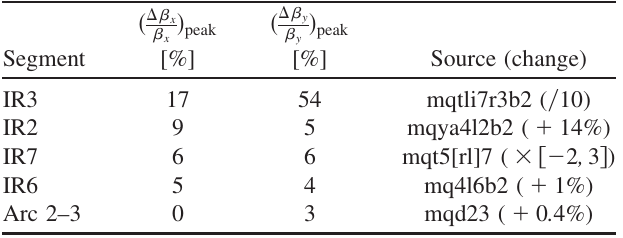
TABLE II. Segment-by-segment summary. The second and third columns show the impact of the error on the ideal lattice. The first and fourth columns show the segment and the ‘‘best fit’’ corrector. Only the IR3 error has been confirmed as a real